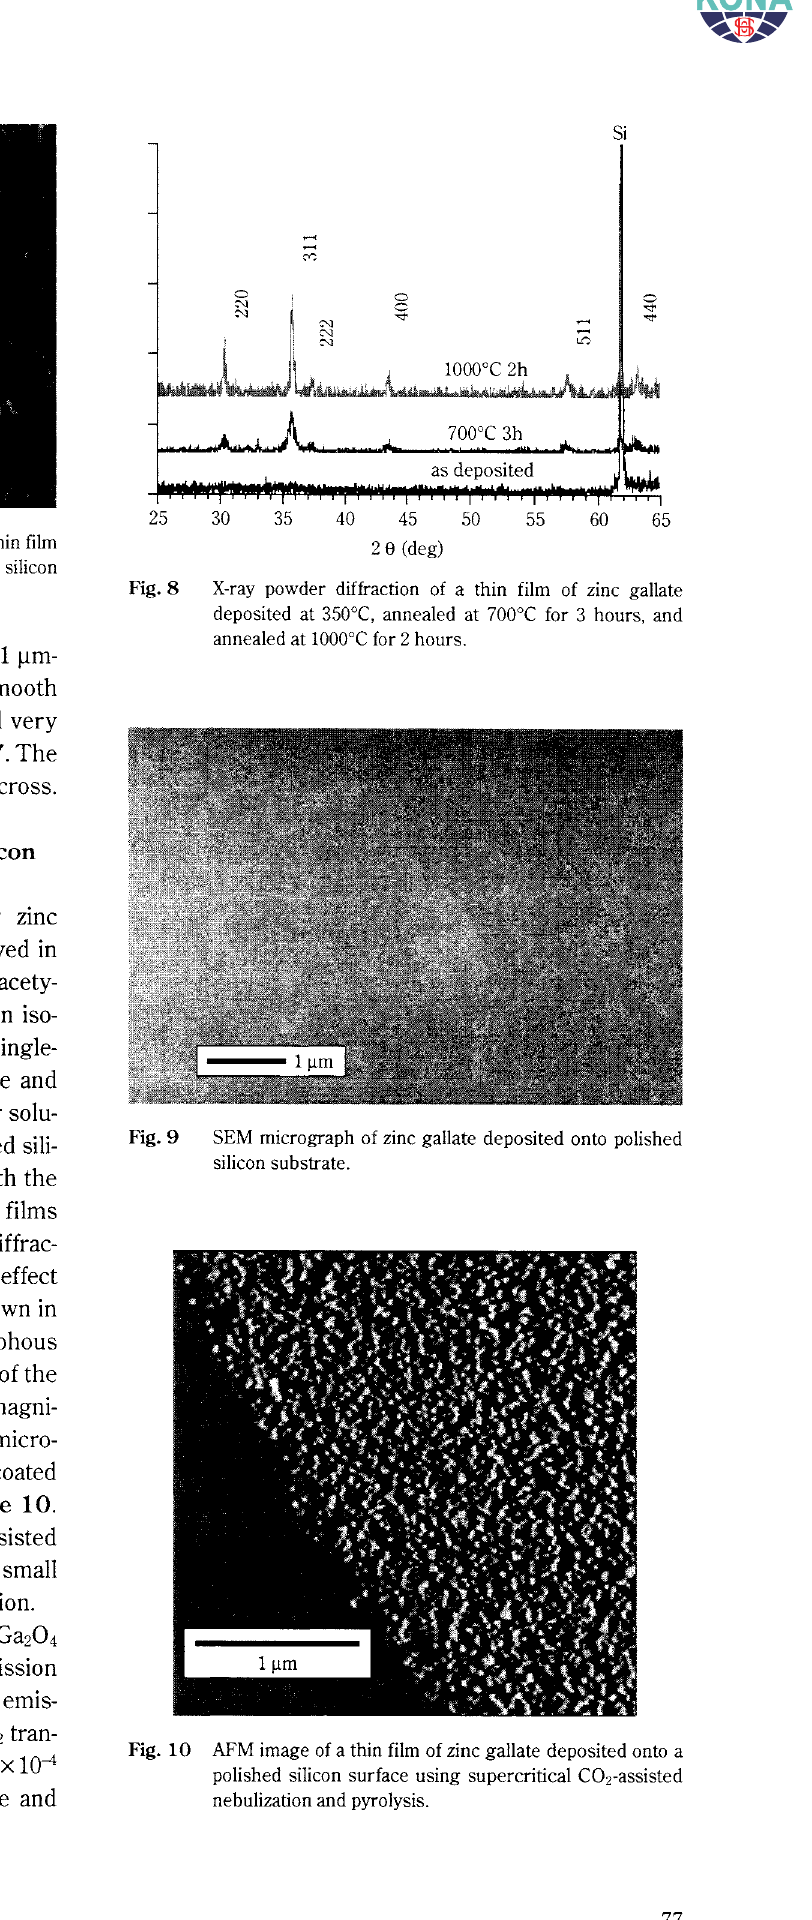
SEM micrograph of the surface morphology of a thin film ( < 1 J.Lm) of zinc oxide deposited onto a polished silicon surface. Fig. 8 X-ray powder diffraction of a thin film of zinc gallate